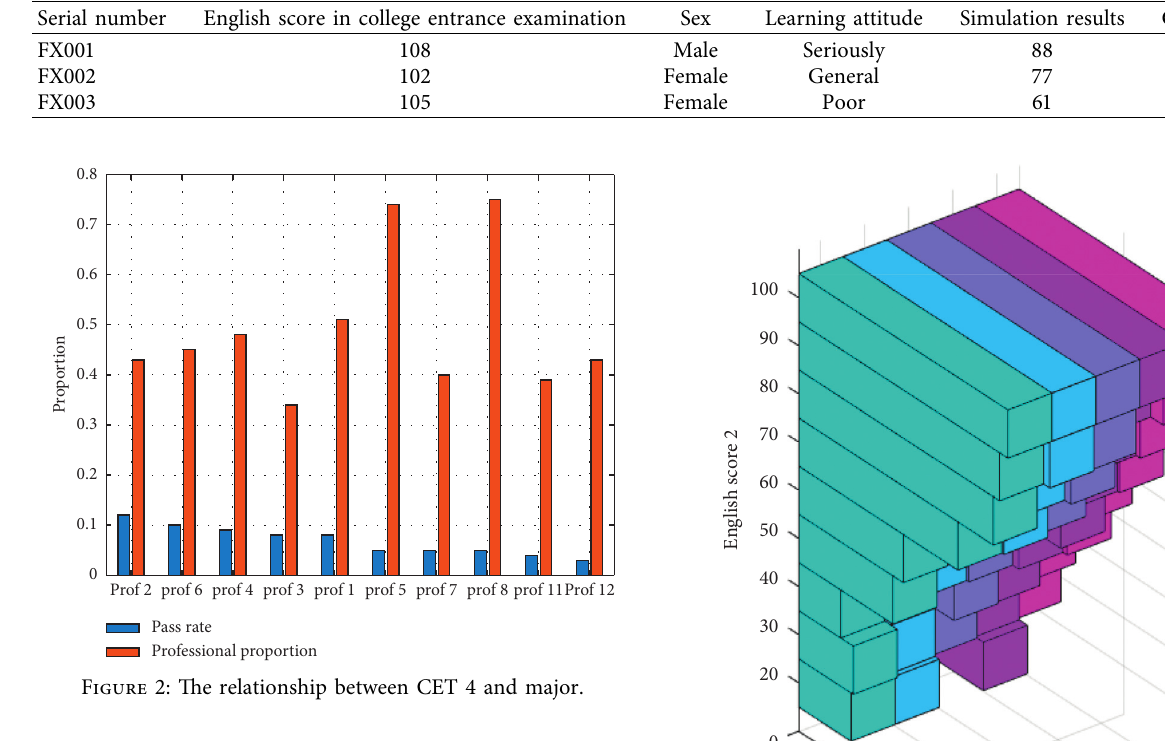
Table 1: Student data table.